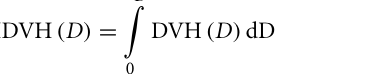
FIGURE 3 |Top: IDVH of NEMA phantom 17mm hot-sphere comparing DPK convolution and the local deposition method, as determined from 8, 20min scans according to recon 1 inTable 1 . Reconstruction was performed using 4mm isotropic voxels with 1 iteration, 21 subsets, and TOF. Both experimental IDVH are compared to the true dosimetric solution IDVH. Bottom: error